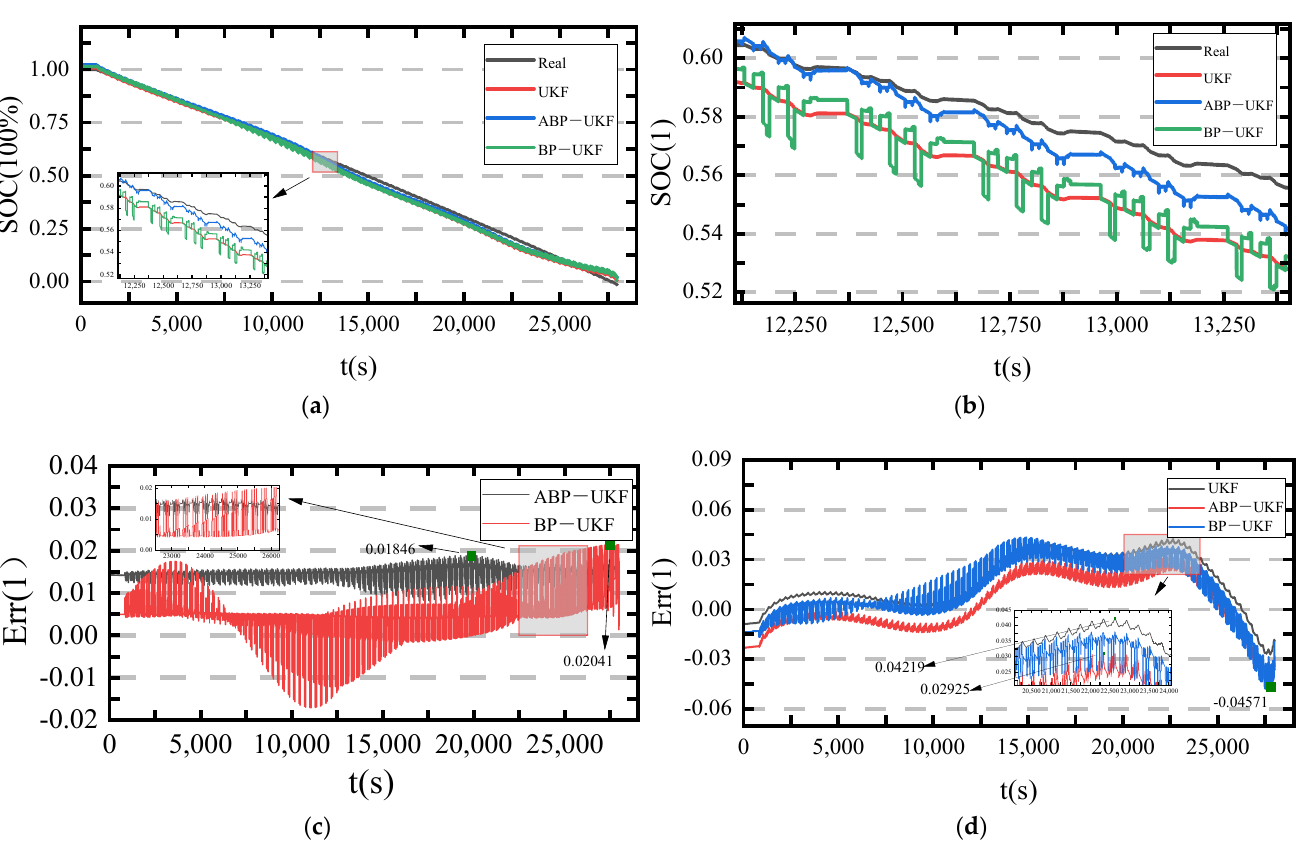
Figure 9. SOC estimation and error comparison under BBDST. ( a ) Estimation results of the SOC under the BBDST working conditions. ( b ) Enlarged view of the estimation results of the SOC under the BBDST working conditions. ( c ) Correction value based on the UKF algorithm. ( d ) Error of the SOC under the BBDST working